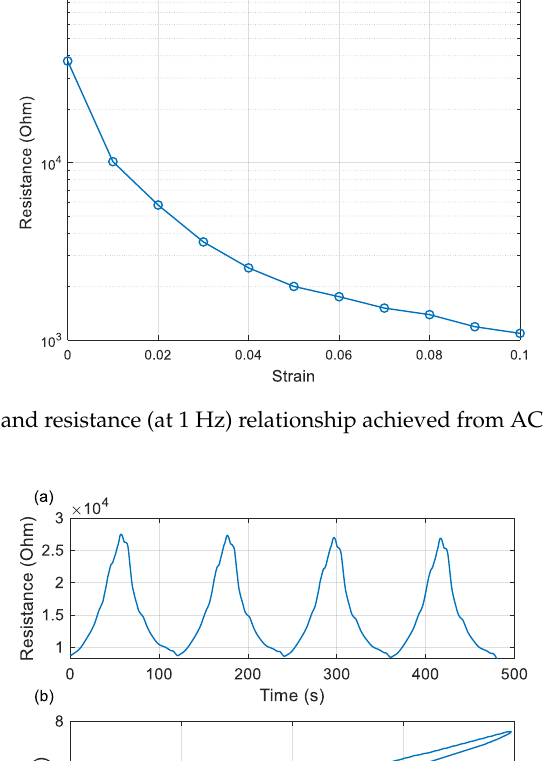
Figure 5. Strain and resistance (at 1 Hz) relationship achieved from AC admittance test.